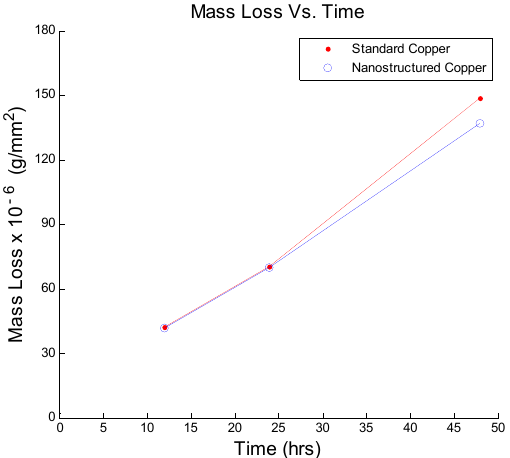
Figure 5. Mass loss versus time for both standard and nanostructure copper.